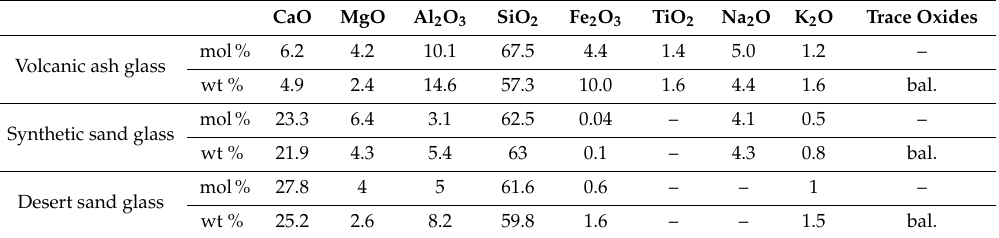
Table 1. Composition (in mol % and wt %, determined by inductively coupled plasma atomic emission spectroscopy—ICP-AES) of the volcanic ash glass prepared in this study compared to previously investigated synthetic sand and desert sand glasses [17–19]. Estimated uncertainty for values in the range of 1.0 − 3.0% = ± 10% of actual value, for values in the range of 3.0 − 10.0% = ± 5% of actual value, for values in the range of 10.0 − 25.0% = ± 2% of actual value, for values in the range of 25.0 − 75.0% = ± 1% of actual